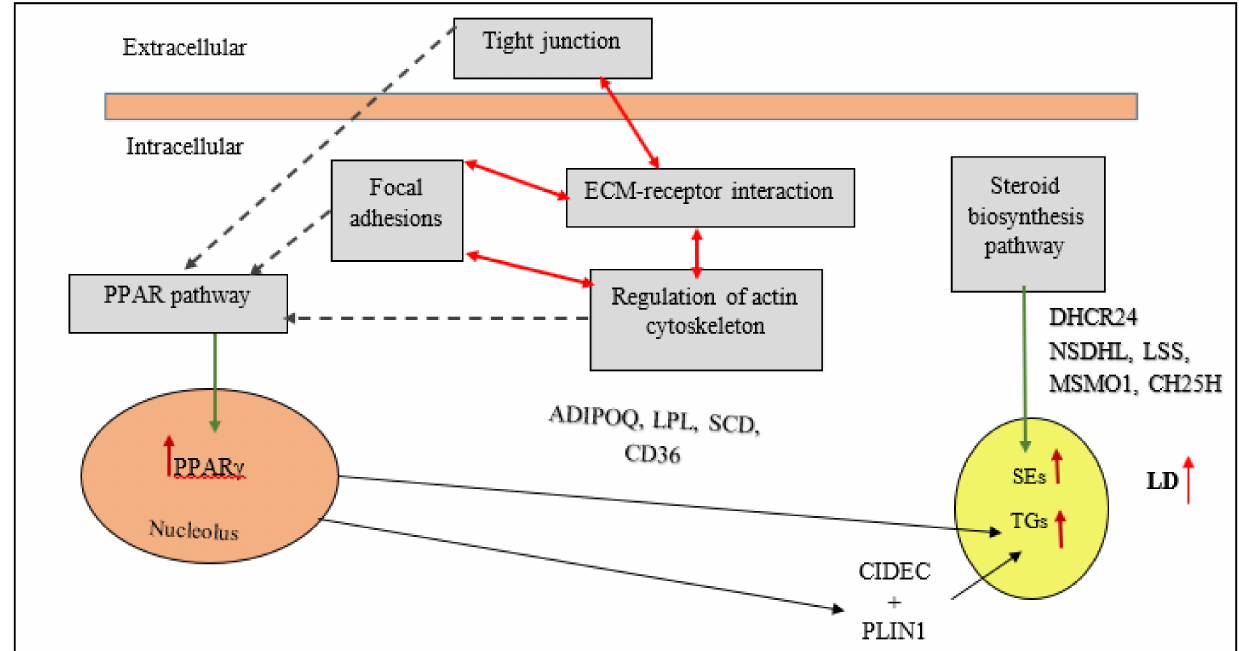
Figure 4. The potential network of signaling pathways contributing to the chicken lipid metabolism. The above-mentioned pathways (gray boxes) might be the crucial pathways for lipid deposition in chicken breast muscle. Activation of PPAR γ in the PPAR signaling pathway leads to upregulation of lipogenic genes, including ADIPOQ, LPL, SCD, or CD36, to promote TG synthesis. Moreover, PPAR γ may promote the interaction of PLIN1with CIDEC to accelerate LD formation. Meanwhile, upregulation of cholesterol synthesis genes, such as DHCR24 and NSDHL, in the steroid biosynthesis pathway may upgrade the steroid ester synthesis. Ses, Sterol esters; TGs, Triglycerides; LD, lipid droplet; PLIN, Perilipins; PPAR γ , peroxisome proliferator-activated receptor γ ; ADIPOQ, adiponectin; LPL, lipoprotein lipase; SCD, stearoyl-CoA desaturase; CD36, cluster of differentiation 36; DHCR24, 24-dehydrocholesterol reductase; NSDHL, NAD (P) dependent steroid dehydrogenase- like; LSS, Lanosterol synthase; MSMO1, Methylsterol monooxygenase 1; CH25H, Cholesterol 25-hydroxylase. Black, red, and green arrows indicate possible regulatory relationship, bidirectional regulatory relationship, and reported regulatory relationship, respectively. Figure 4 was adapted from [23] with